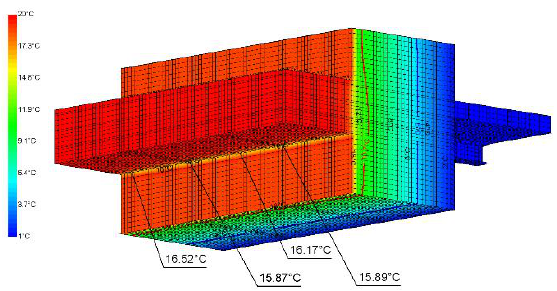
Figure 21. Internal surface temperature distribution field on the wall and deck—bottom view.